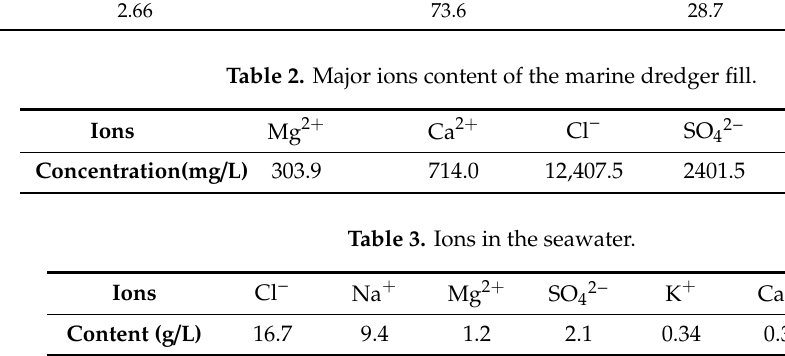
Table 1. Basic physical parameters of the marine dredger fill.